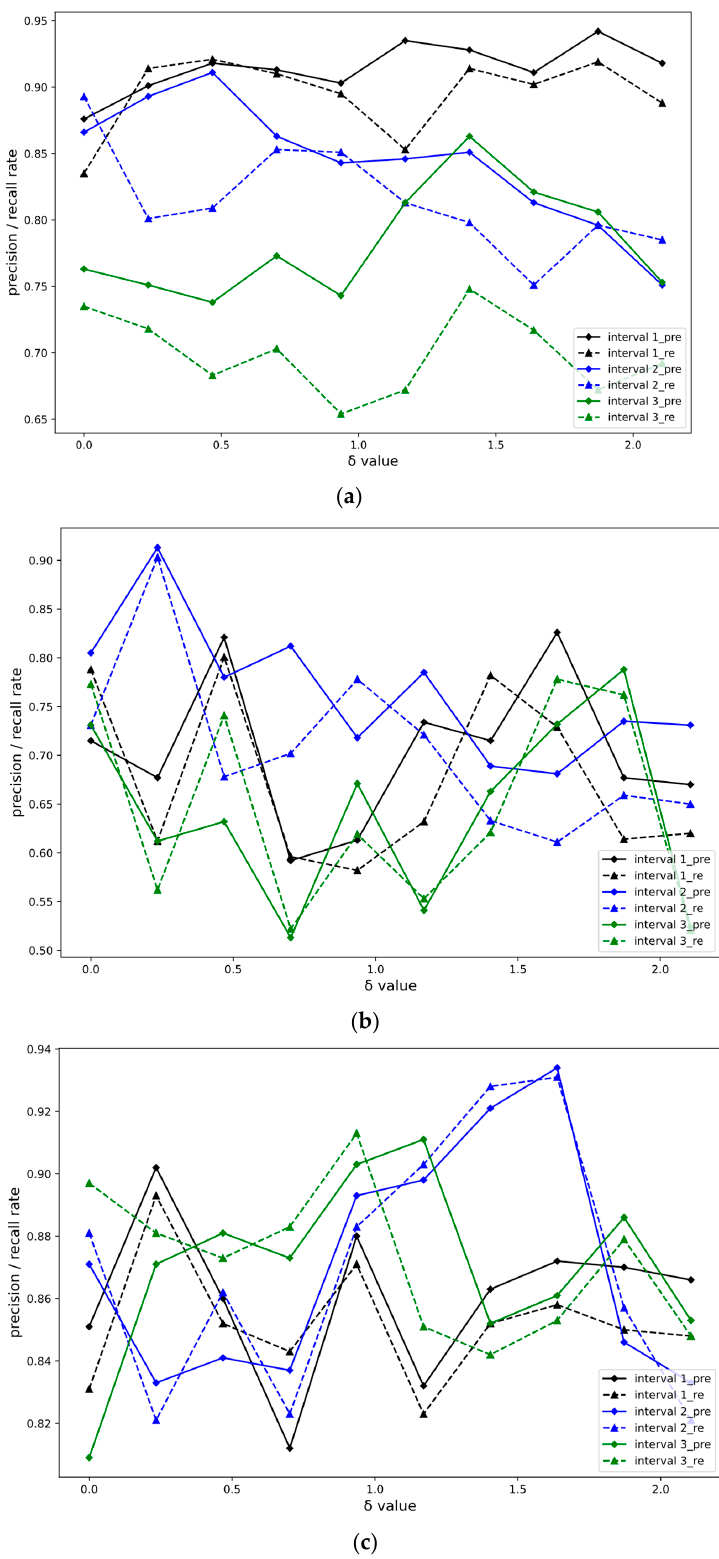
δ , βα intervals. ( a ) in di ff erent ）（ 11